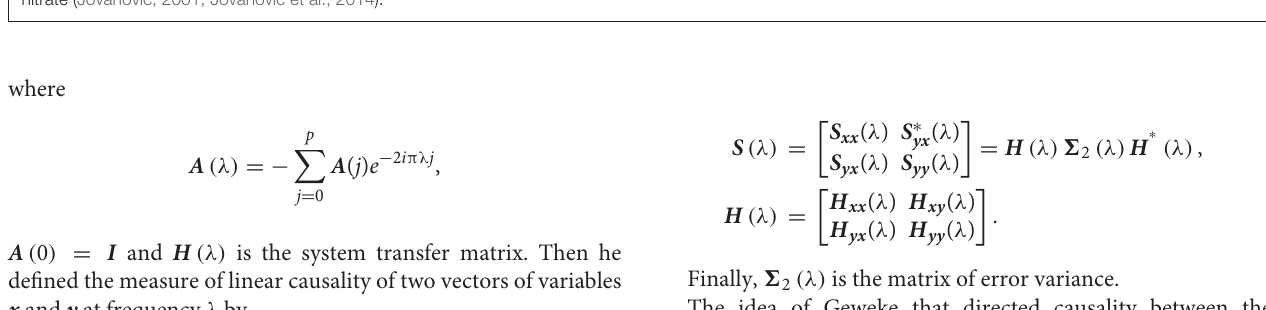
FIGURE 23 | Spectrograms showing the normal AP state and the spectrogram changes and regular feature destructions after administration of scopolamine methyl nitrate ( Jovanovi ´ c, 2001; Jovanovi ´ c et al.,